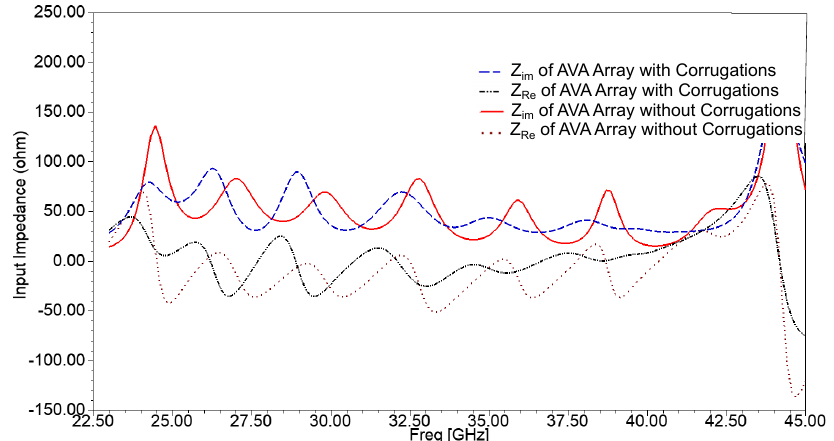
Figure 9. Input impedance of the AVA array with and without corrugations.